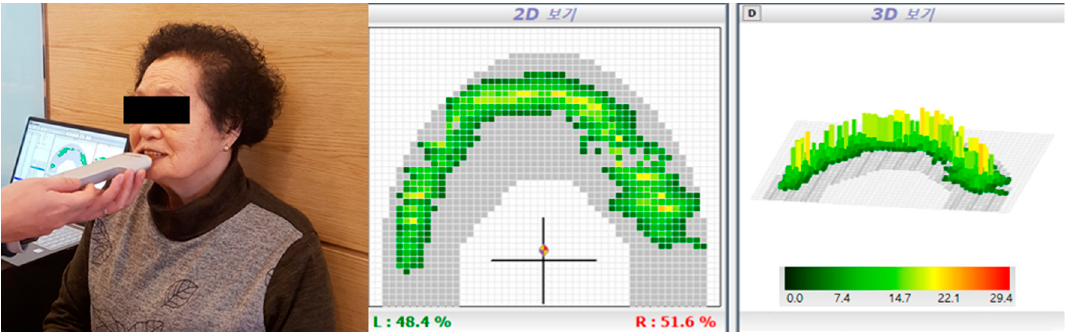
Figure 4. Measurement of the occlusal force. Left panel, image recorded during the actual measurement of the occlusal force; center panel, two-dimensional (2D) image of the measured data; right panel, 3D image of the measured data.